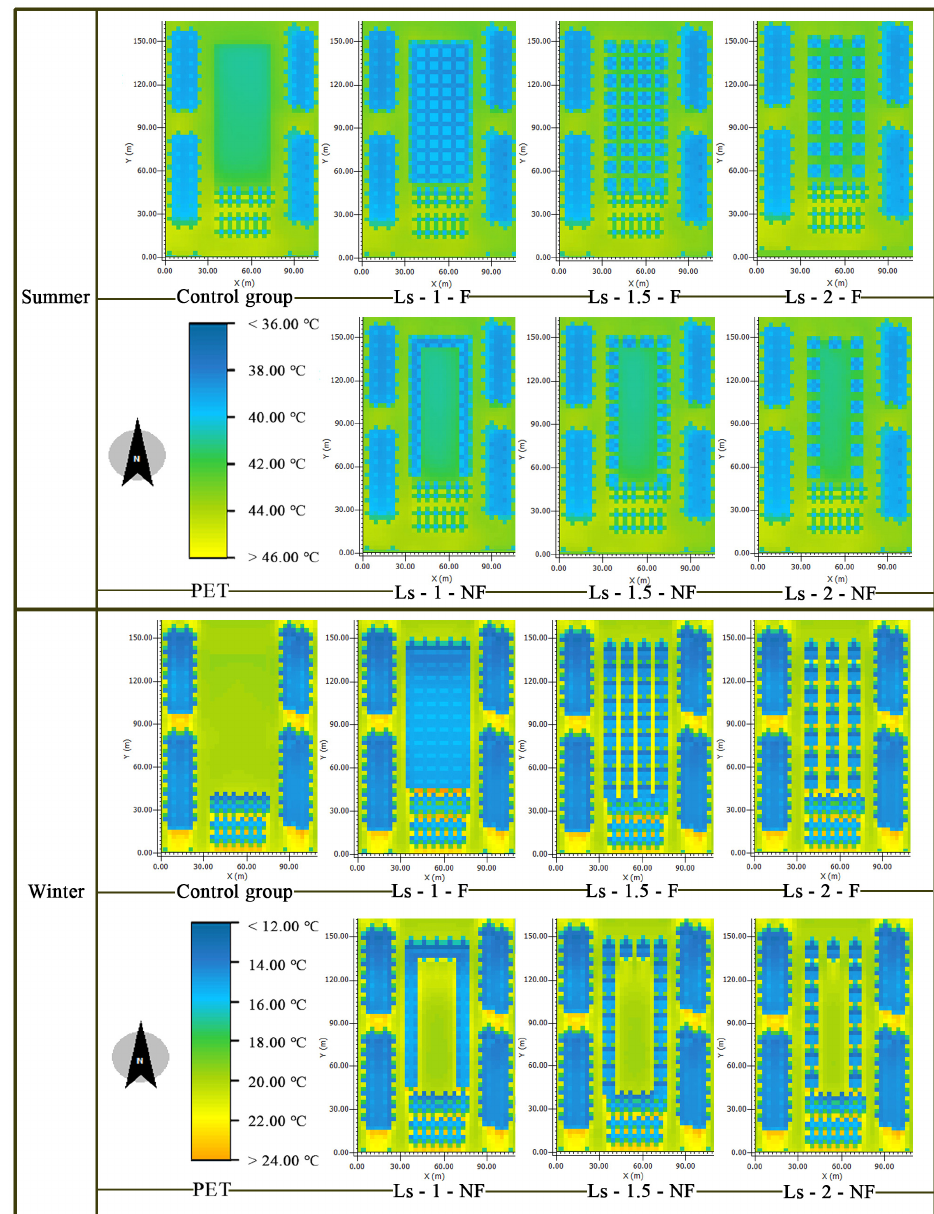
Figure 12. Contour map of PET distribution in different scenarios at 12:00 in summer and winter.